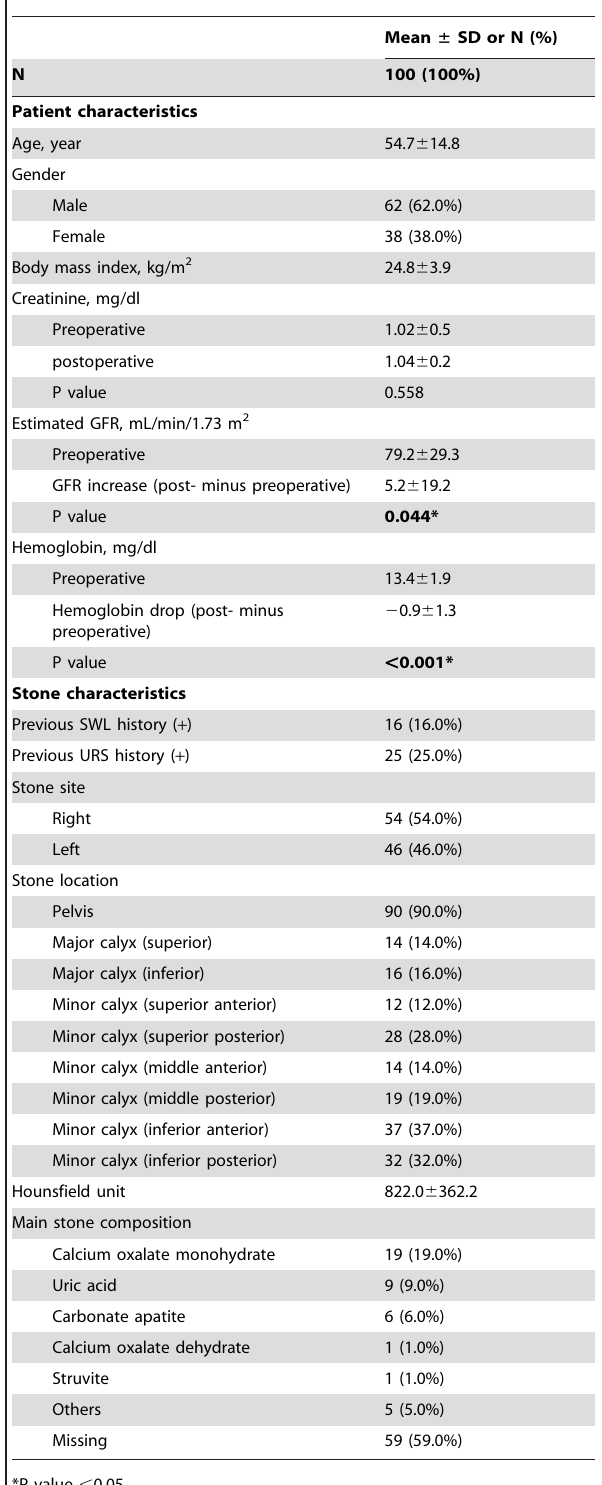
Table 1. Patients and stone